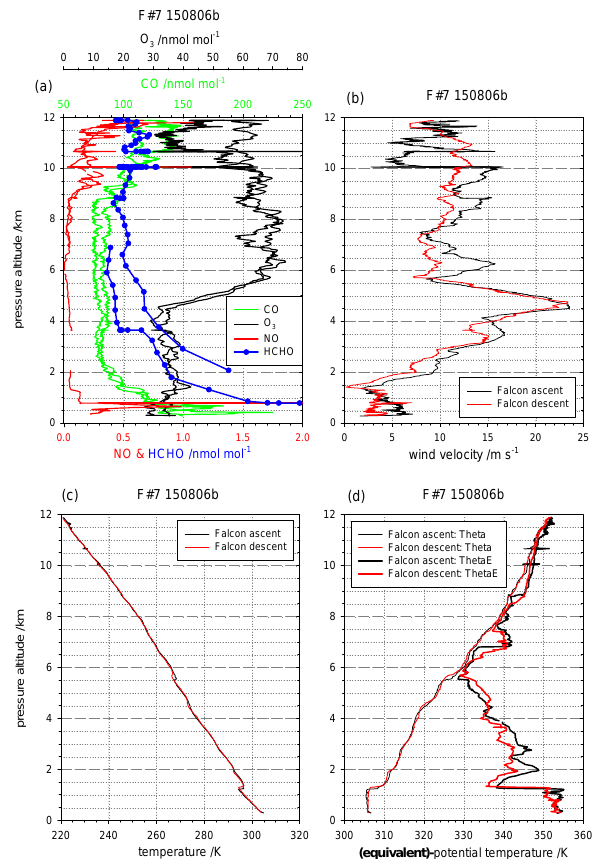
Fig. 9. Vertical profiles for CO, O 3 , HCHO, and NO (a) , wind velocity (b) , temperature (c) , and (equivalent)-potential temperature (d) derived from Falcon measurements on 15 August